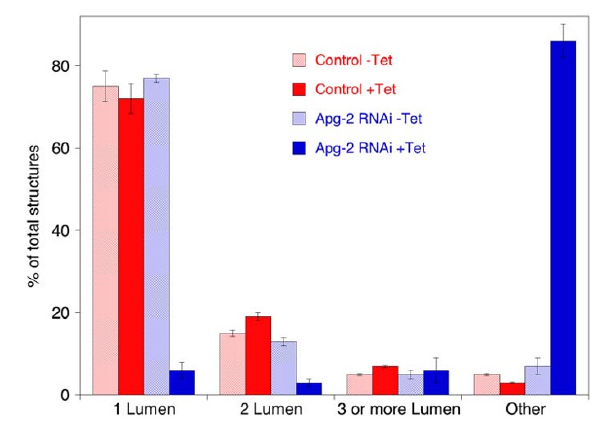
figure 6. In two experiments performed with different batches of matrigel, pictures from ten different areas were taken and quantified by counting the number and types of cultures. The formed structures were divided into the fol- lowing classes: spherical structures with a single lumen; 2 lumen and 3 (or more lumen) but with a normal polarised organisation; and all other structures including cysts with no